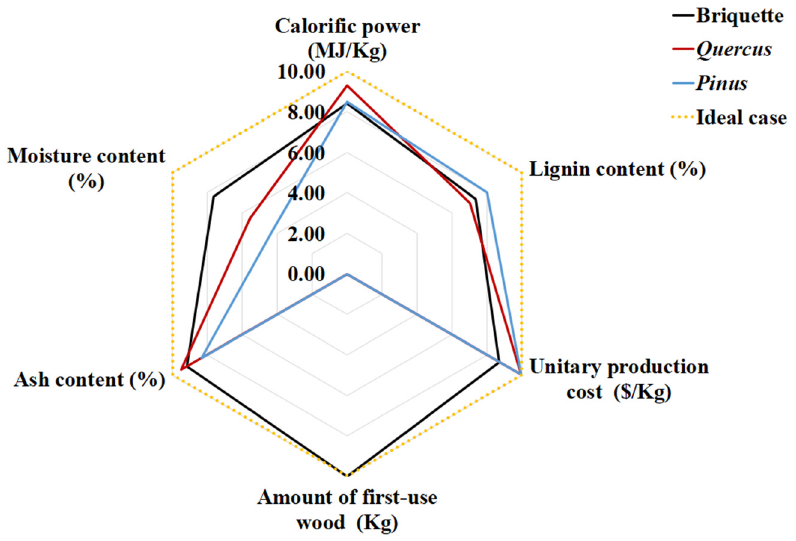
Figure 15. Formulation of indicators with different parameters using the MULTIBERSO program.